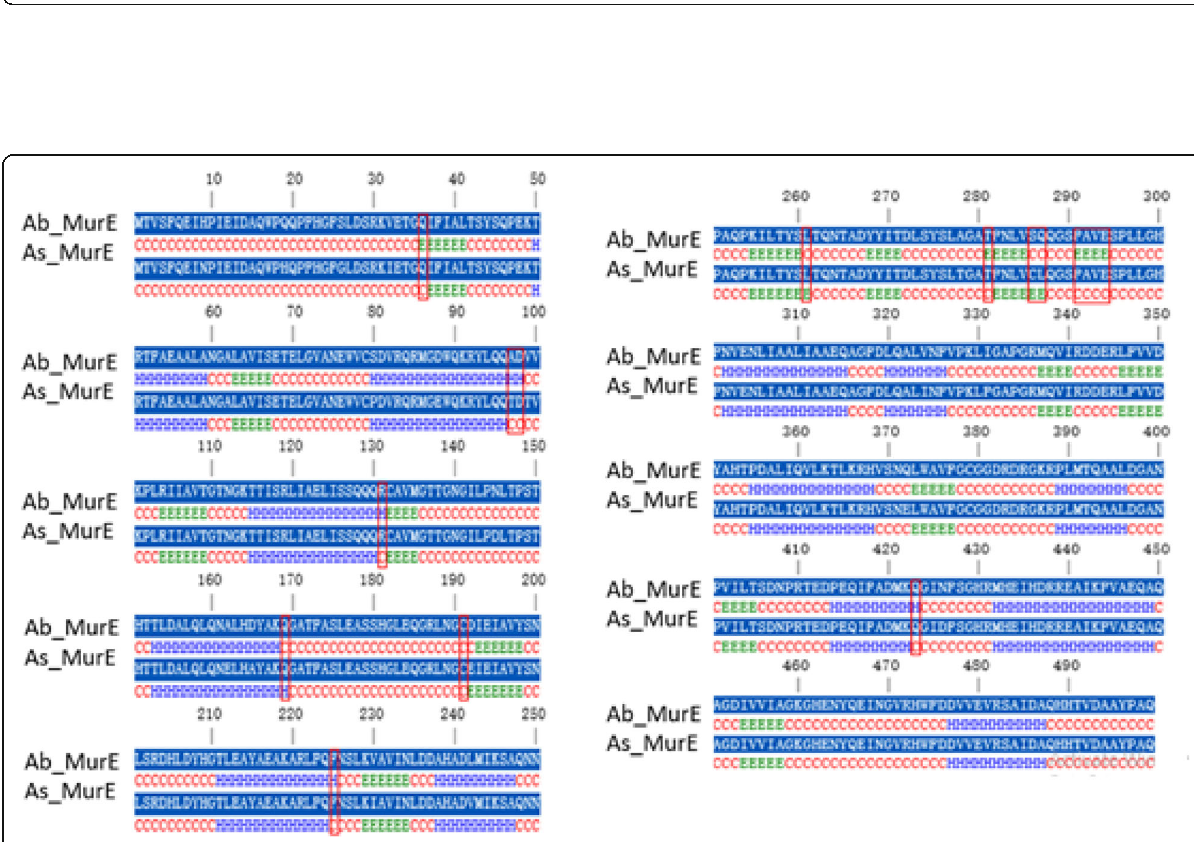
Fig. 14 Conserved secondary structure prediction and comparison of MurB from A . baumannii and A . calcoaceticus. Structurally variable regions in between them were highlighted using red boarded rectangular